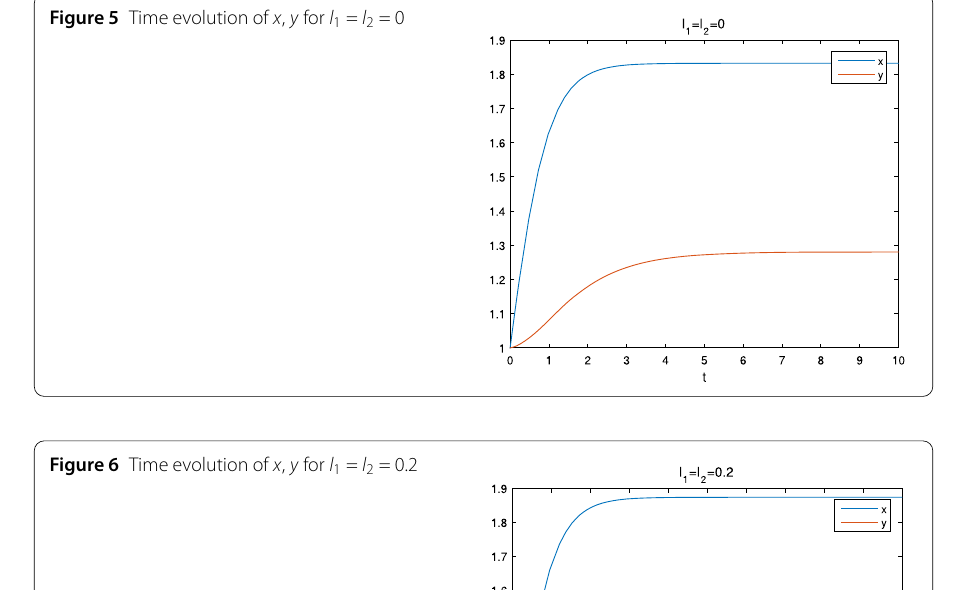
Figure 6 Time evolution of x , y for l 1 = l 2 = 0.2